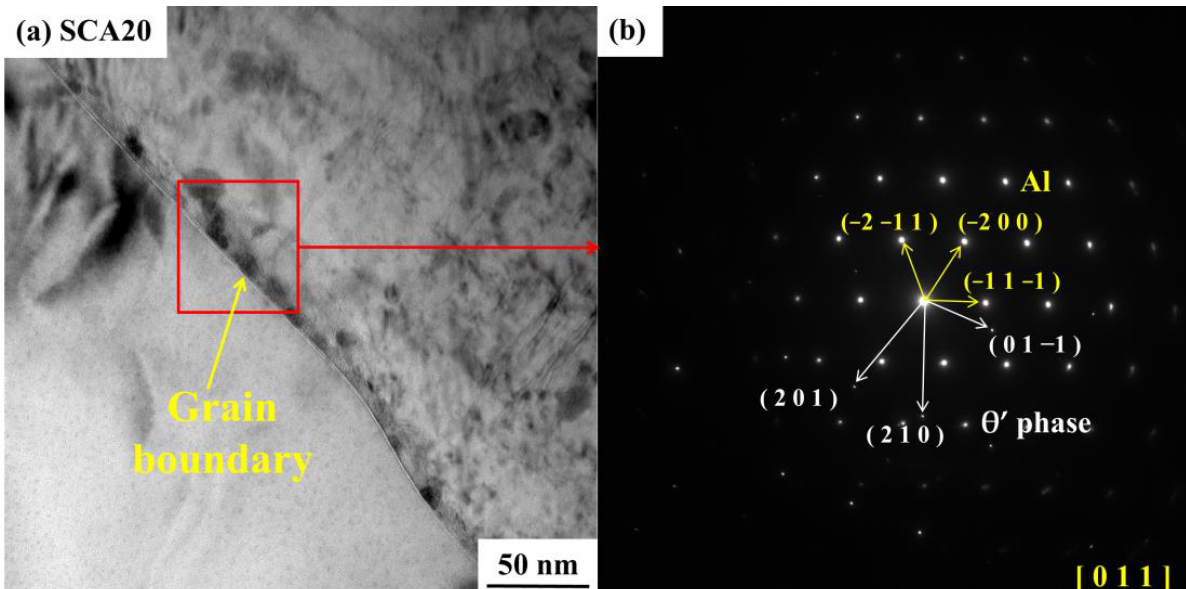
Figure 13. TEM micrographs ( a ) and selected-area electron diffraction (SAED) ( b ) of the 15%SiCp/2009Al composites treated by SCA20.